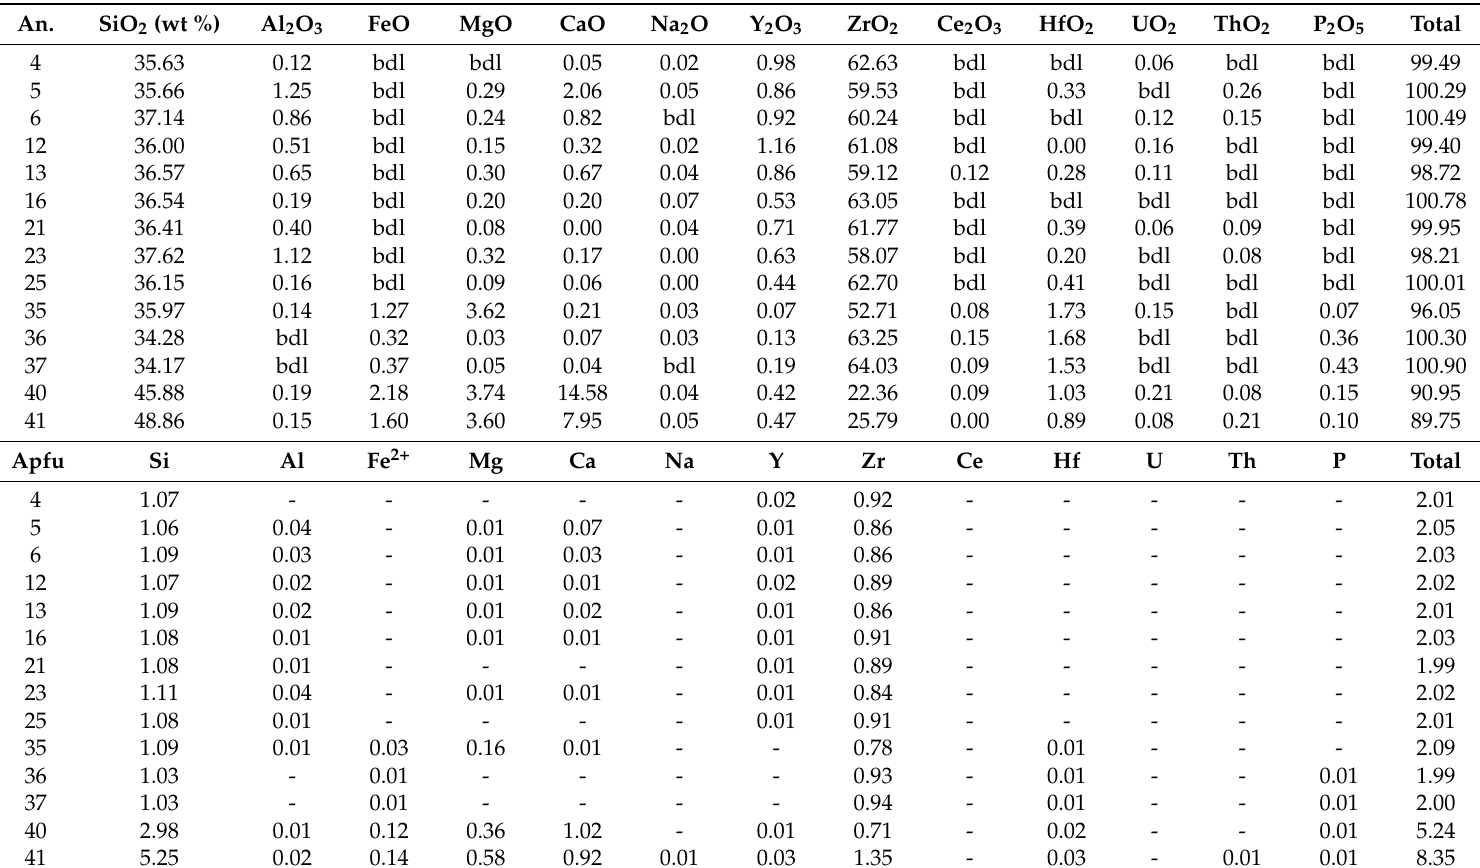
Table A4. Electron-microprobe analyses of Zr-bearing silicate phases from the studied chromitites. All analyses correspond to zircon except for 40 and 41 which represent calciocatapleiite and armstrongite, respectively. Structural formulae for zircon were calculated on the basis of 4 atoms of O, whereas those of calciocatapleiite and armstrongite were calculated on the basis of 9 and 15 atoms of O. Analyses 35–37 correspond to zircon texturally associated with porous spinel and chlorite. The full range of detected major oxides for analyses 40 and 41 is given in the Supplementary files. Abbreviations: An. = analysis number; D.L. = detection limit; bdl = below detection